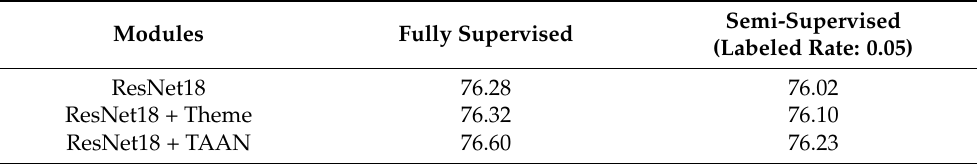
Table 1. Accuracy (%) of different modules. For the semi-supervised method, the value is the accuracy of step 2 ( δ = 1). Semi-Supervised Modules Fully Supervised (Labeled Rate: 0.05) ResNet18 76.28 76.02 76.32 76.10 76.60